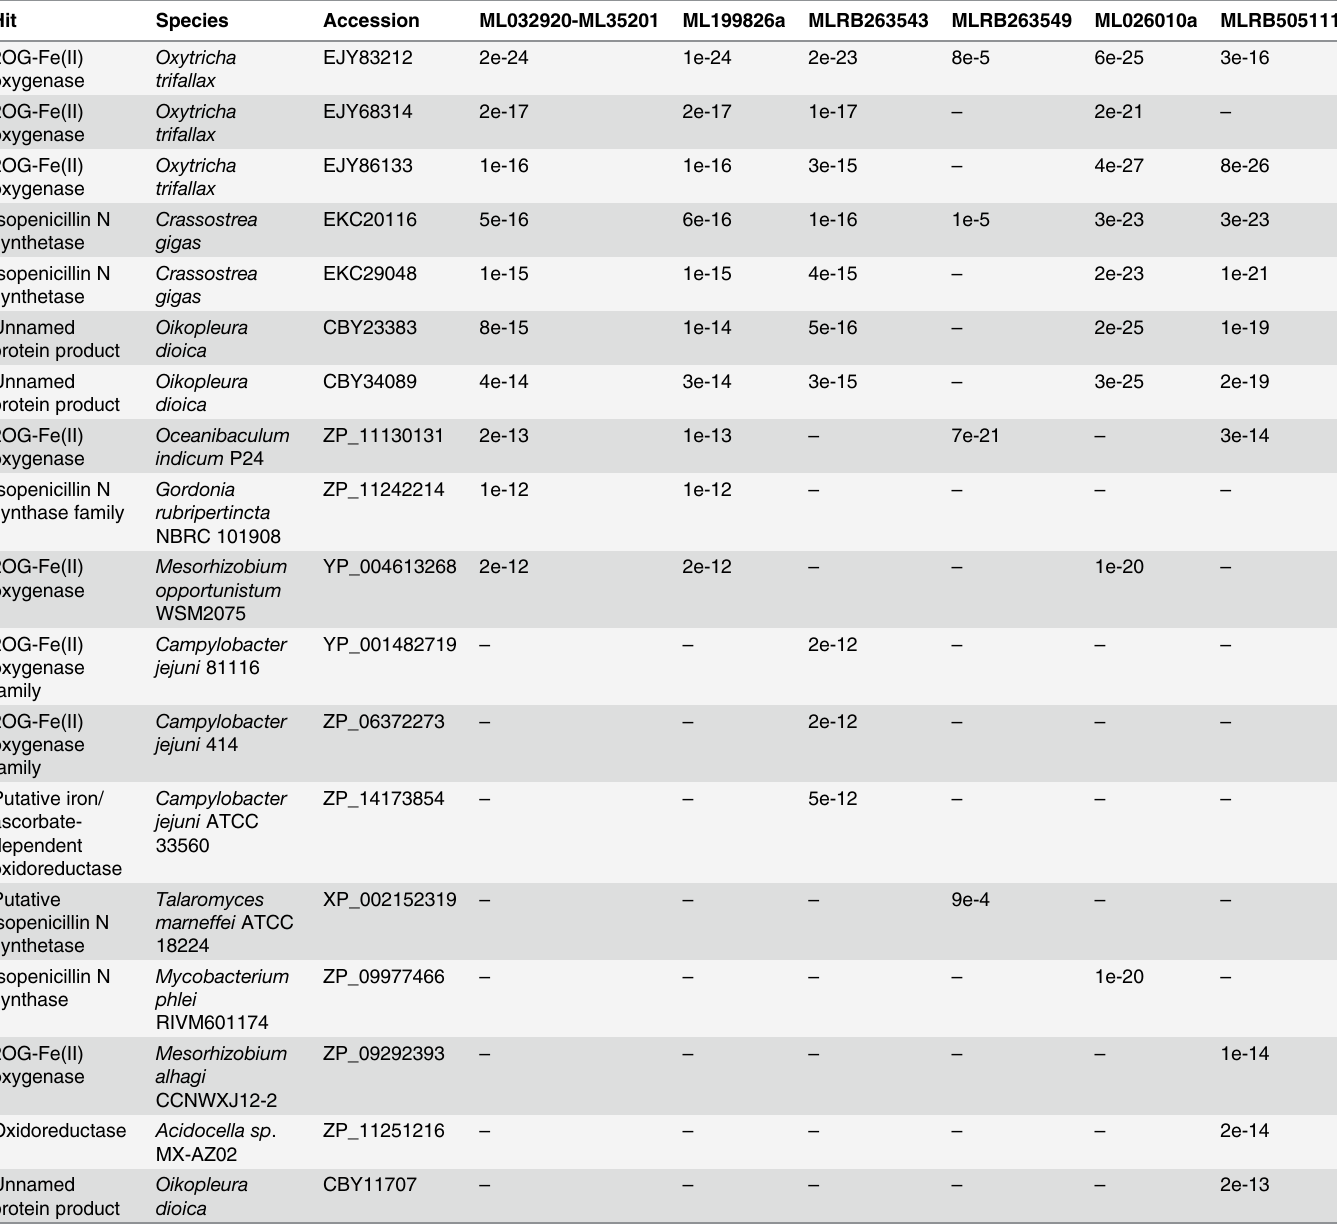
Table 3. Top BLAST hits for FYY proteins in nr.